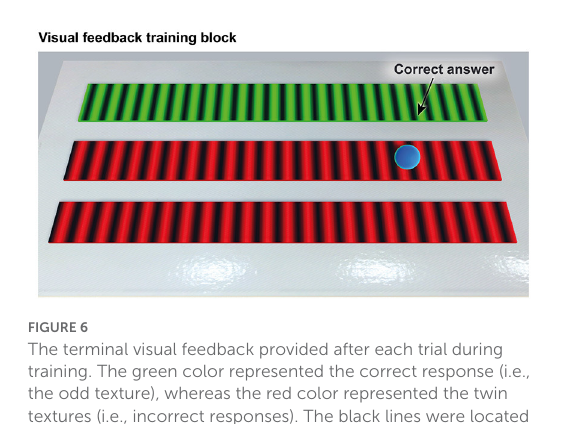
FIGURE6 The terminal visual feedback provided after each trial during training. The green color represented the correct response (i.e., the odd texture), whereas the red color represented the twin textures (i.e., incorrect responses). The black lines were located along the grooves of the textures. Participants were allowed to re-explore the textures as